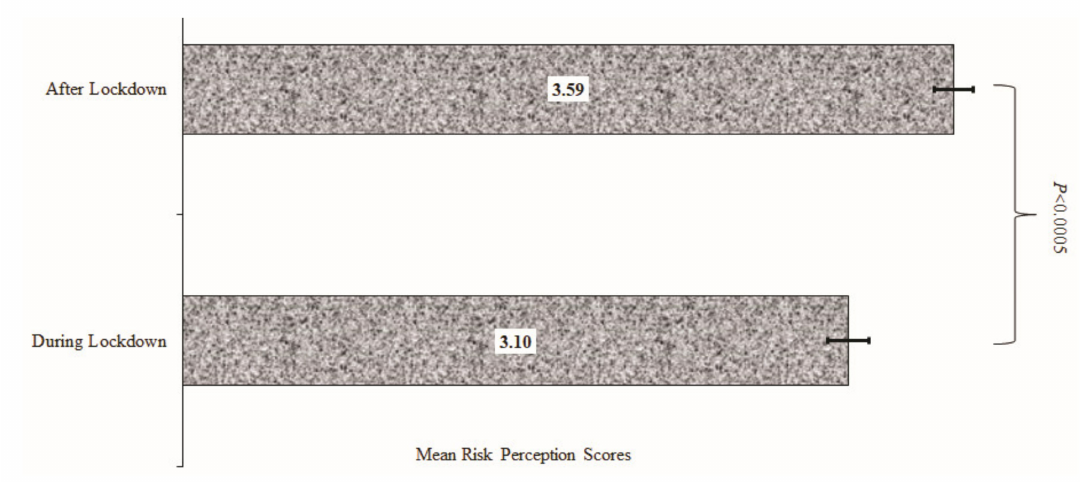
Figure 2. Mean score for the perceived risk of contracting COVID-19 after and during